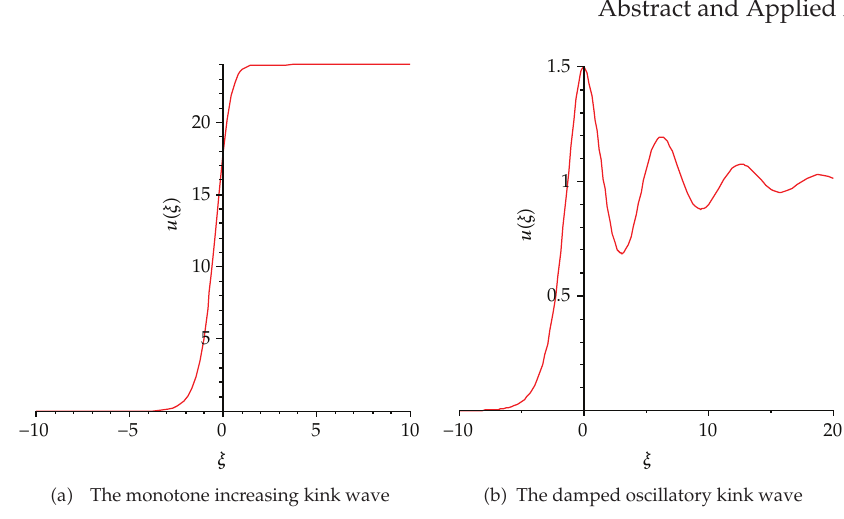
Figure 5: The monotone and oscillatory kink